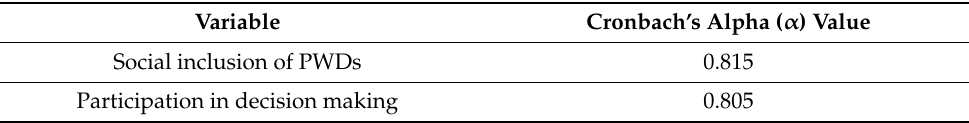
Table 1. Cronbach’s alpha ( α ) results/values of